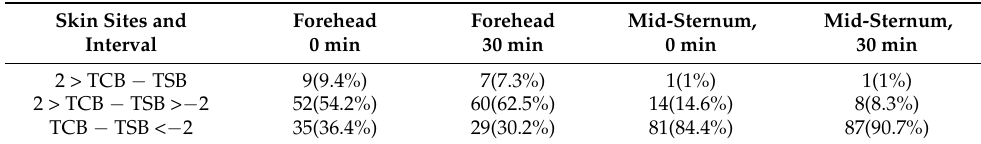
Table 4. Distribution of differences between TCB and TSB measurements.